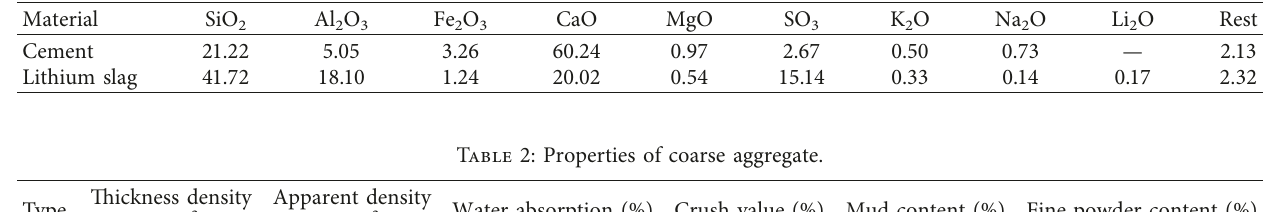
Table 1: The chemical composition of cement and lithium